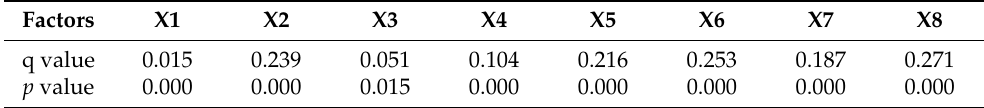
Table 4. q values of natural and human